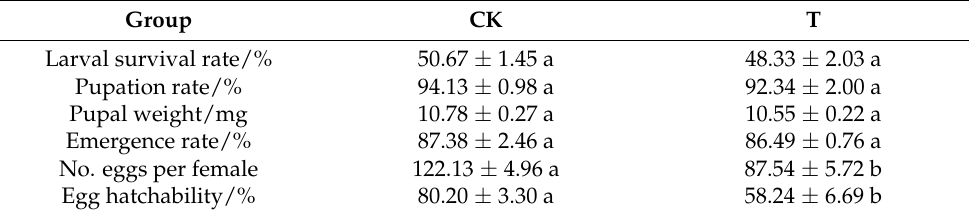
Table 6. Effects of antibiotics on growth, development, and reproduction of Grapholita molesta .